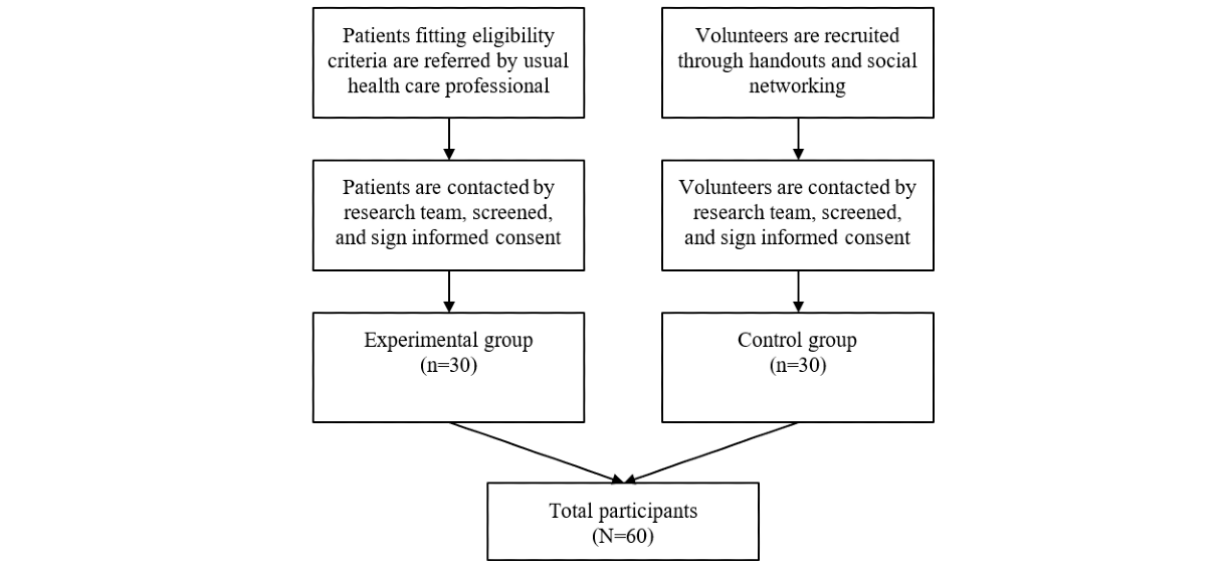
Figure 1. Study recruitment